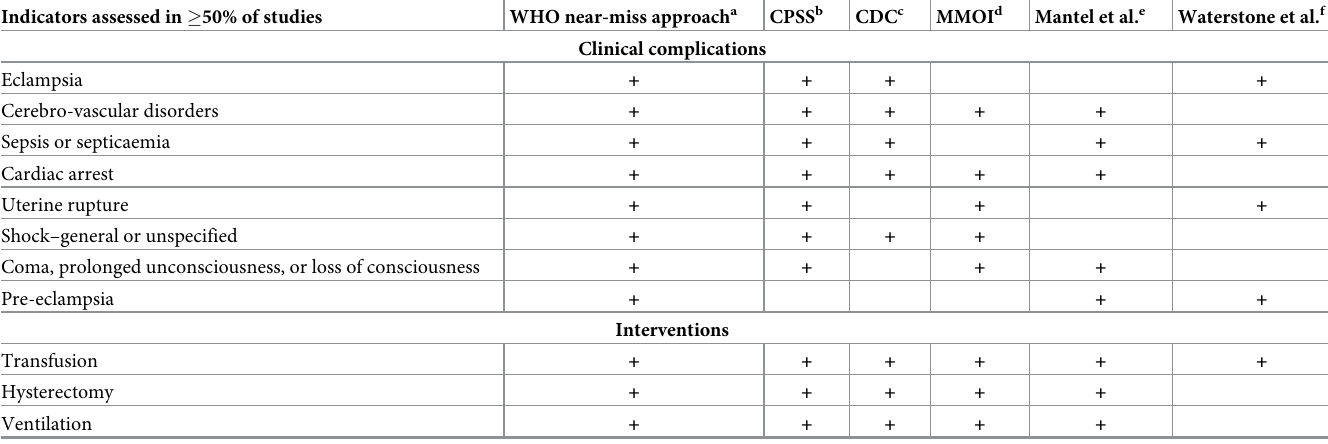
Table 1. Common MNM/SMM surveillance methods and their use of indicators related to those assessed in > 50% of included studies. Indicators assessed in � 50% of